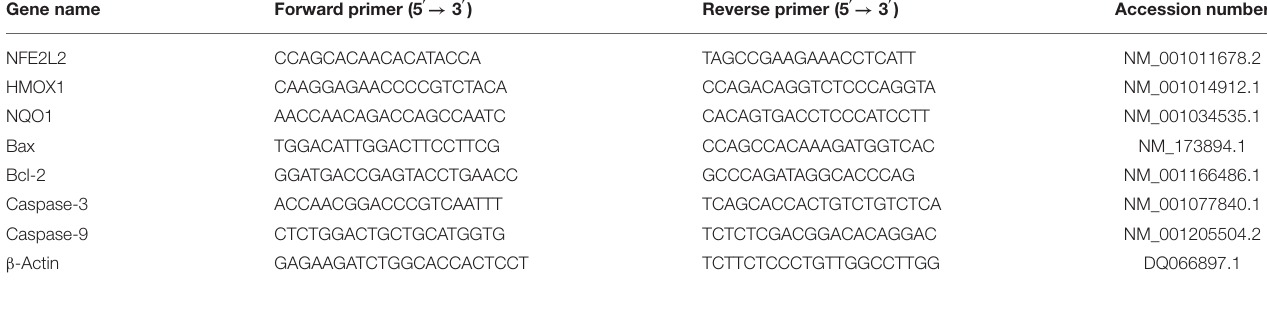
TABLE 1 | Primer sequences of the genes.